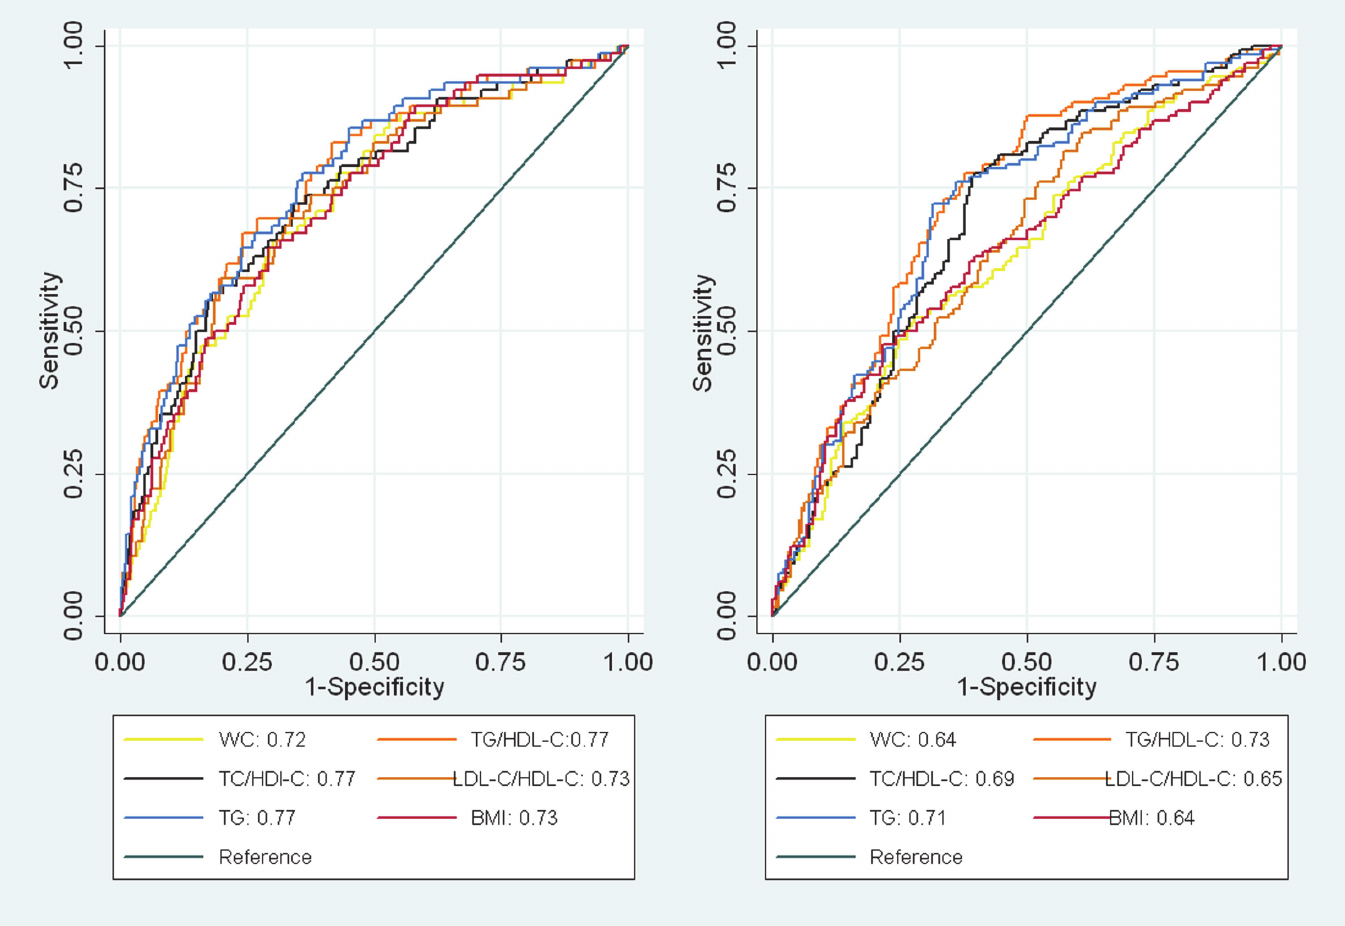
Figure 2. a. AUROC curves for potential markers of HOMA-IR in normal-weight women. b. AUROC curves for potential markers of HOMA-IR in overweight/obese women.